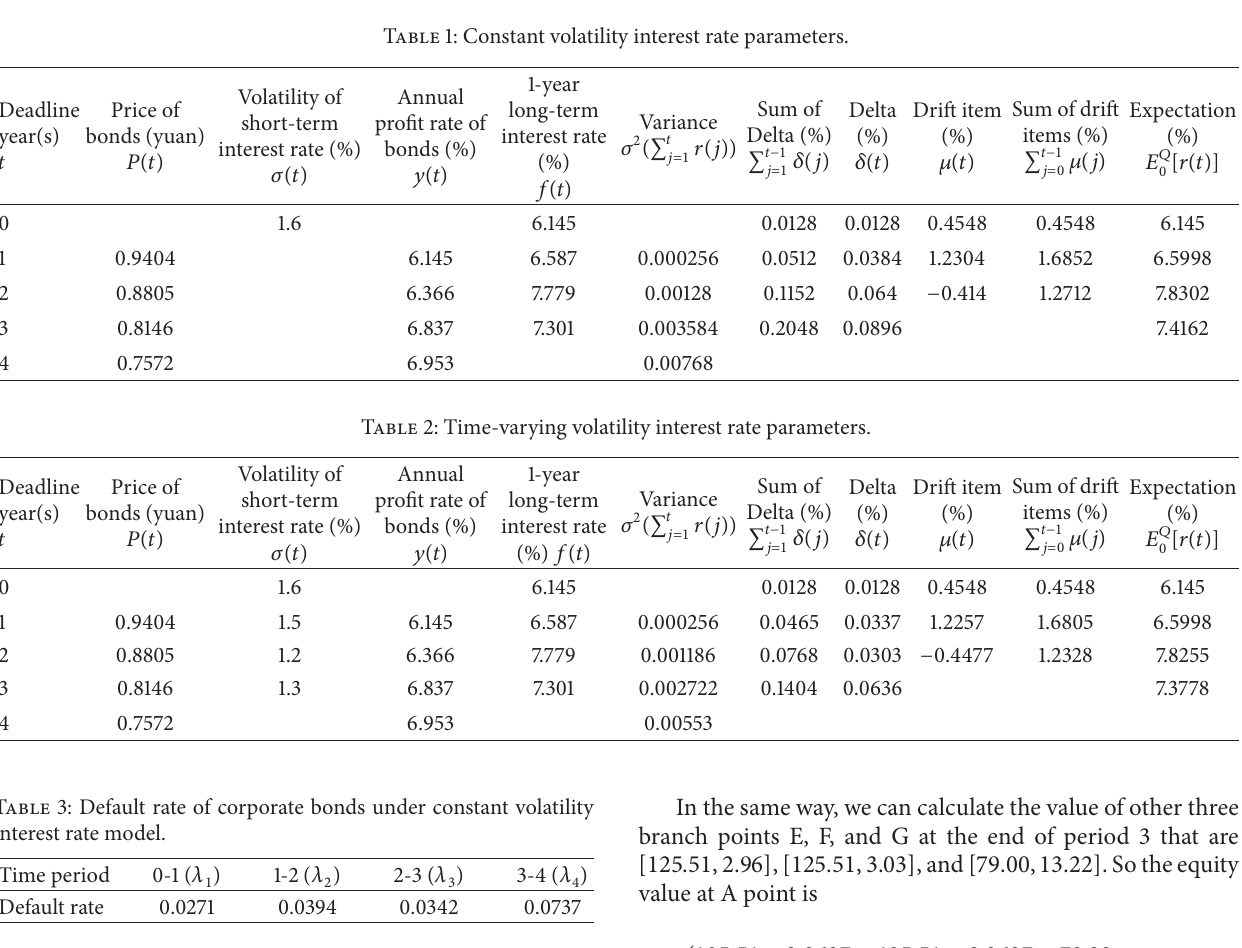
Table 4: Default rate of corporate bonds under time-varying volatility interest rate